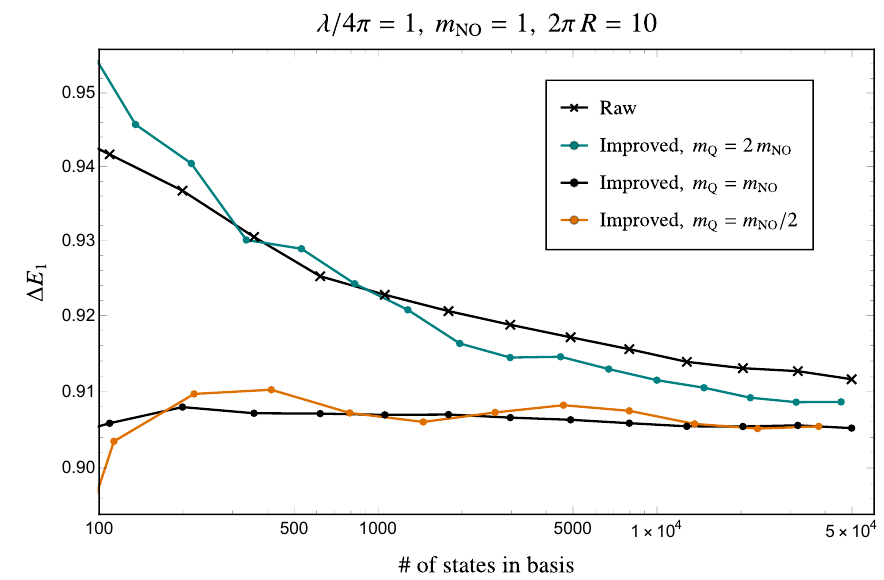
Fig. 9. The ground state excitation energy ∆ E improved theory [ dots ] for m the size of the basis to better compare the convergence given finite computational re- sources. The data points are connected by lines to guide the eye. This figure includes data points for theories with up to 5 × 10 4 states in the basis. With this upper bound, we probe theories with E